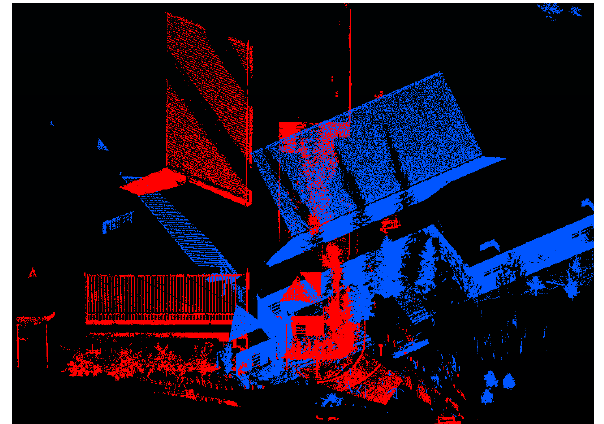
Figure 5. Two subsampled point clouds of Rozsa center before registration